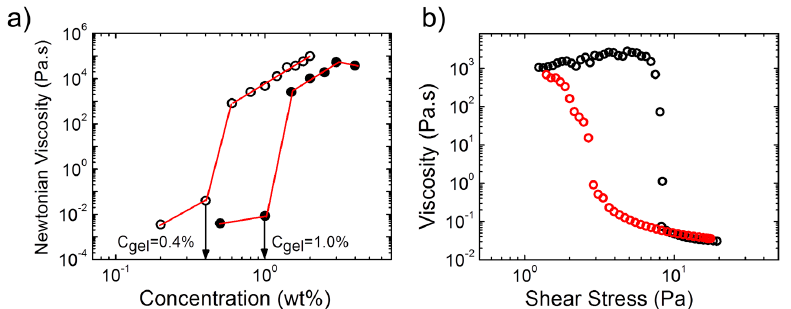
Figure 3. ( a ) Concentration dependence of the zero shear viscosity at the pH of maximum viscosity for A(QP)A 2 (closed symbols) and APA 2 (pH 2.9) (open symbols). Lines along the data guide the eyes and arrows indicate the gelation concentration. ( b ) Apparent viscosity versus shear stress of 1.6 wt % aqueous A(QP)A 2 solution at pH 3: increasing stress (black circles) and decreasing stress (red circles). Adapted with permission from [34]. Copyright 2014 American Chemical Society.